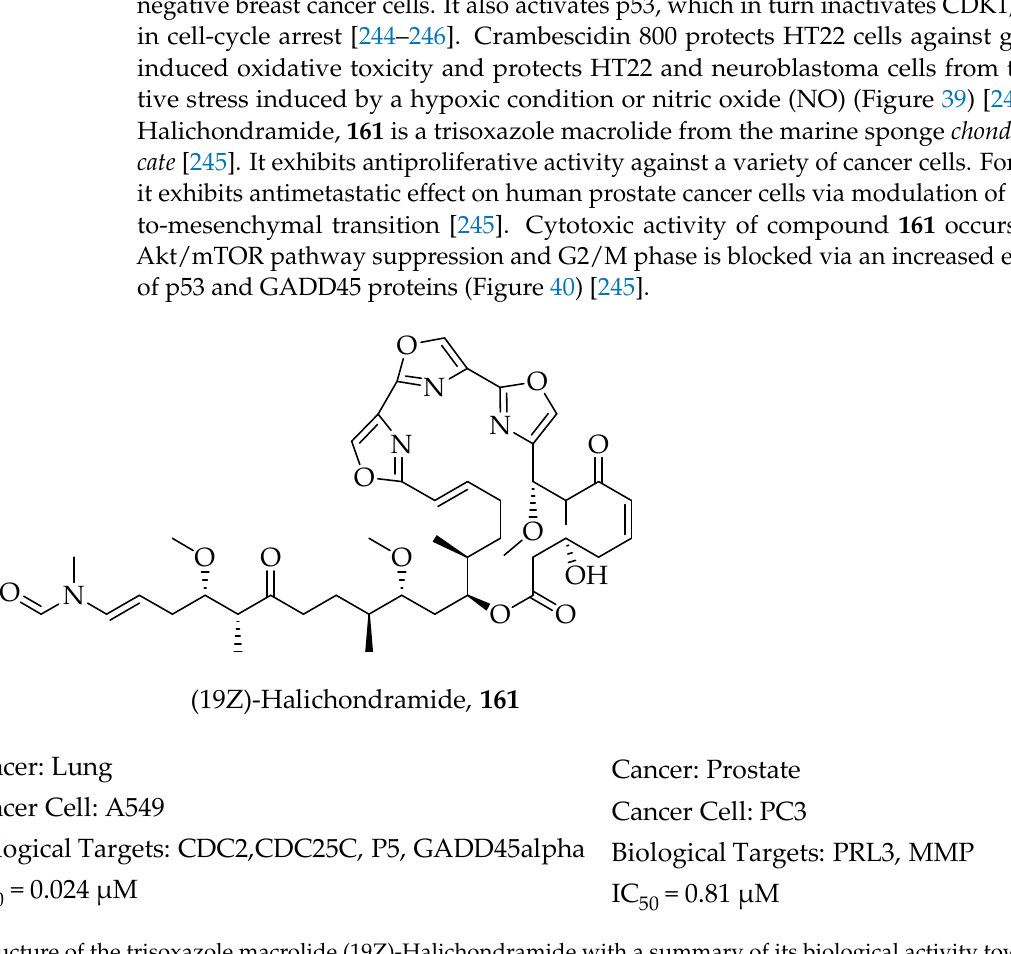
Figure 40. Structure of the trisoxazole macrolide (19Z)-Halichondramide with a summary of its biological activity towards selected cancer targets.